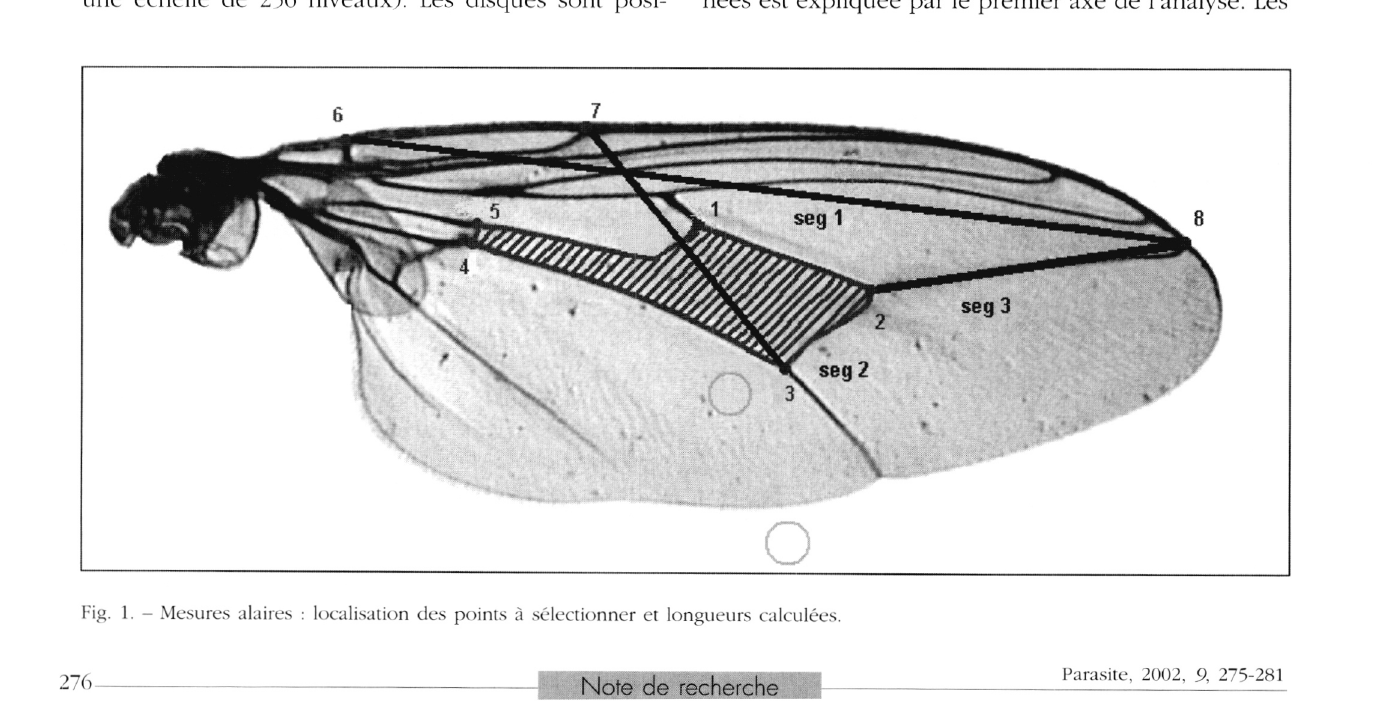
Fig. 1. - Mesures alaires : localisation des points à sélectionner et longueurs calculées.